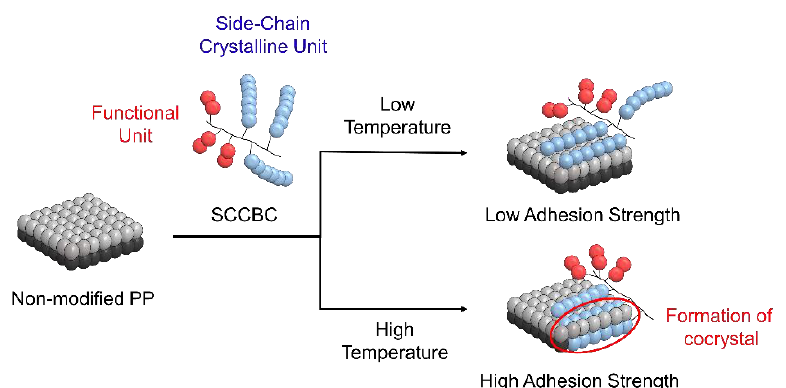
Figure 9. Schematic diagram of the plausible mechanism of PP modified with the SCCBC.